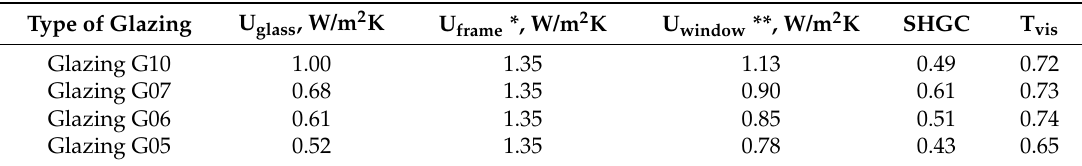
Table 1. Visible and solar energy parameters of the glazing.